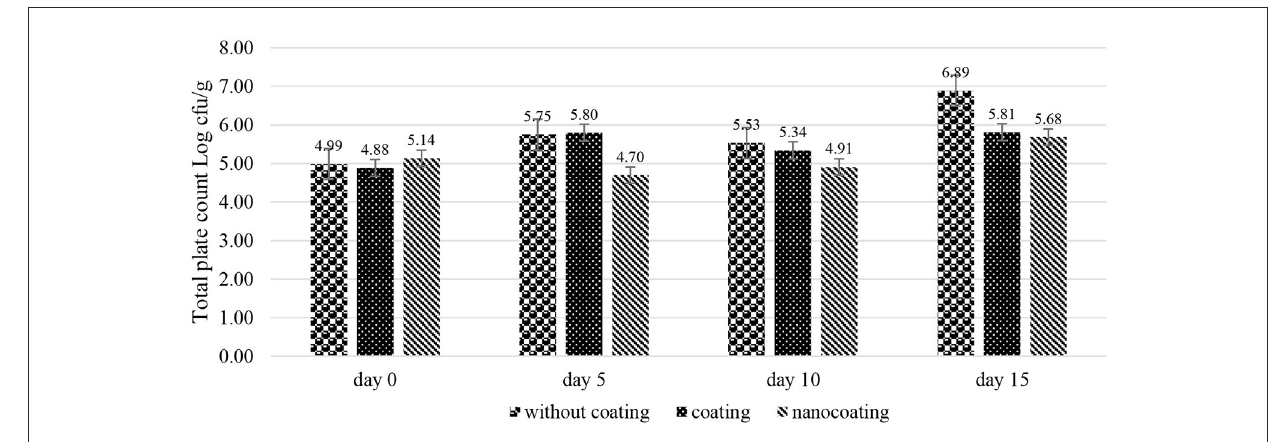
FIGURE8 Total plate count (log cfu/gram) of Siamese